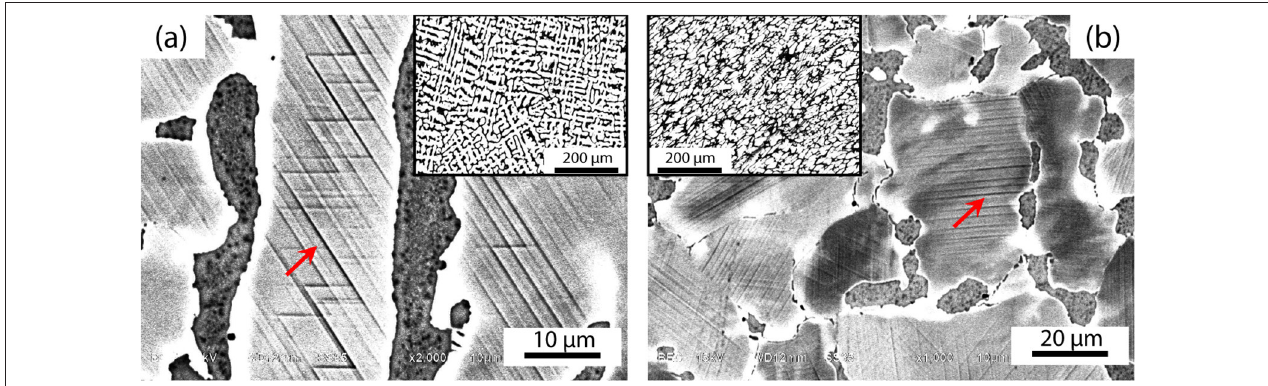
FIGURE 3 | Post-loading microstructures in (a) columnar and (b) equiaxed regions where sliding planes (some are indicated with a red arrow) are clearly visible. The small inserts show OM micrographs of the samples after loading